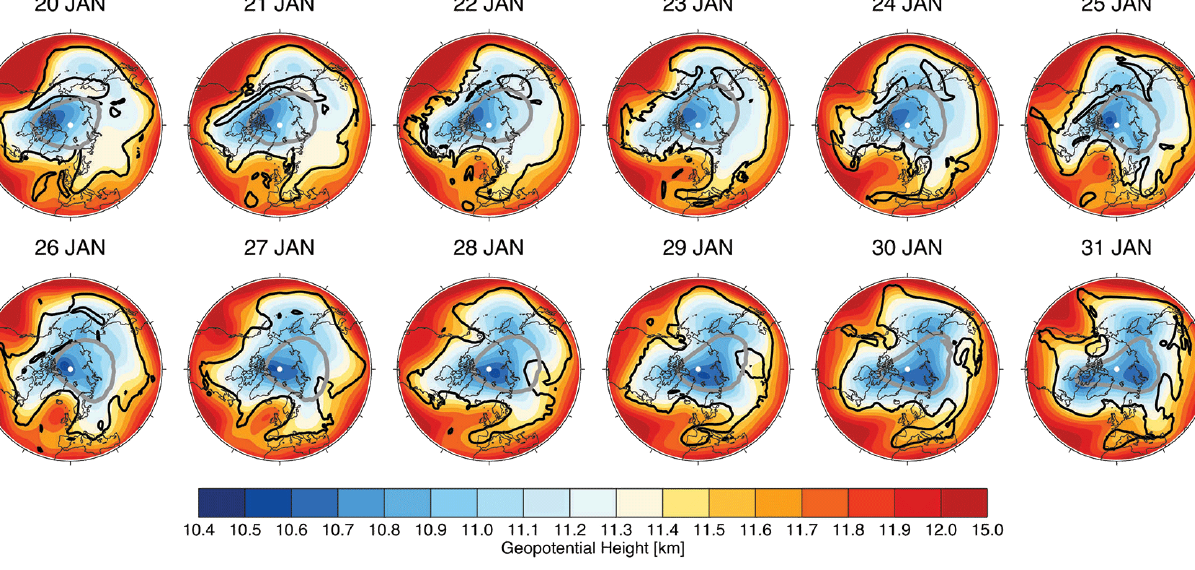
Fig. 16. As in Fig. 15 except for geopotential